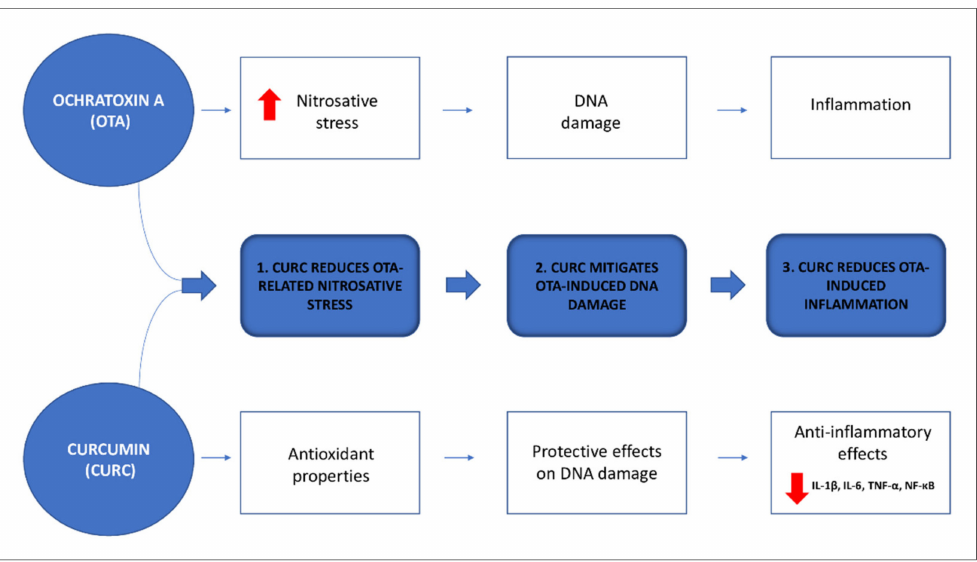
Figure 1. Schematic illustration of the working hypothesis of the present